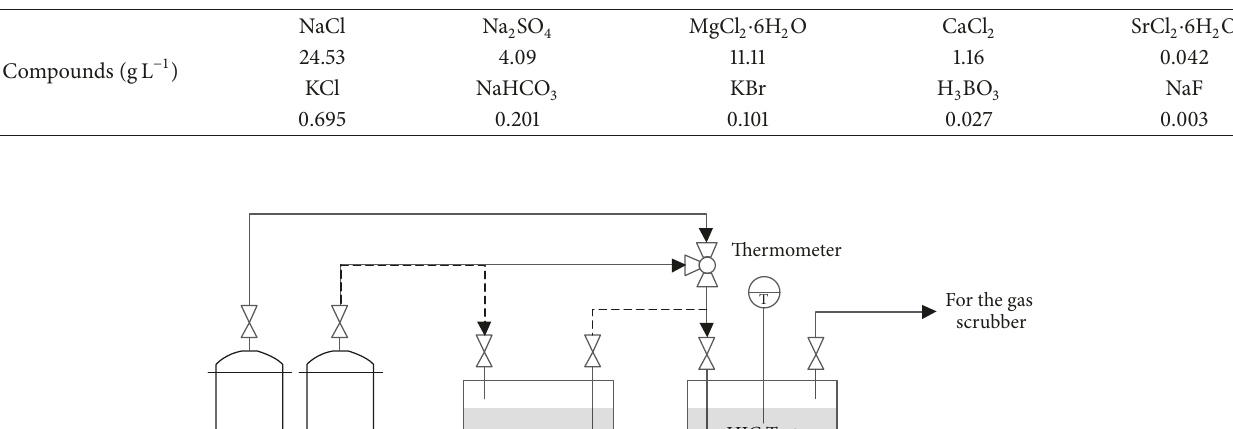
Table 4: Composition of solution 284-B adjusted to pH 8.2 with NaOH.